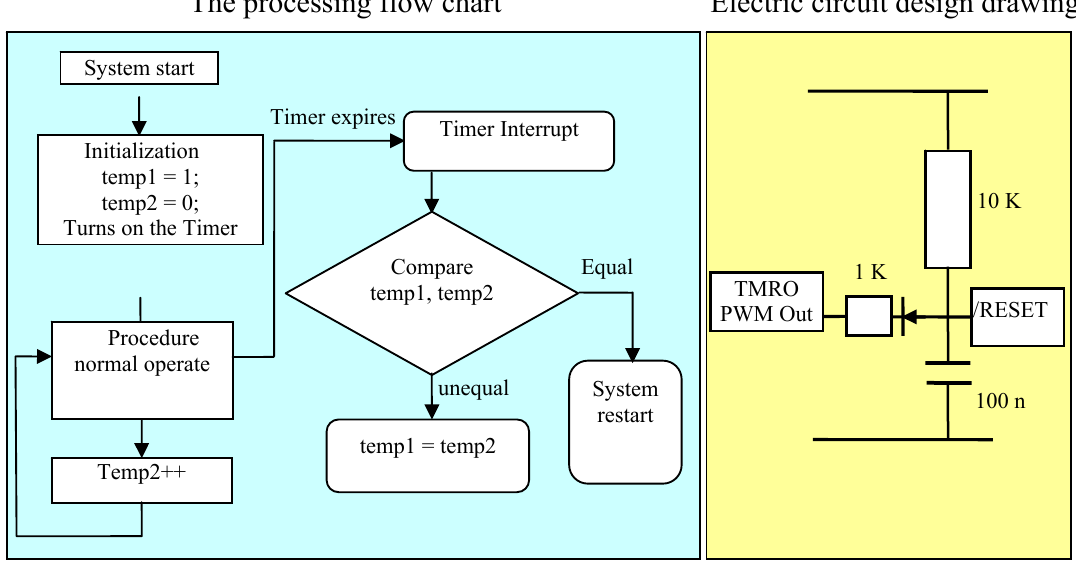
Figure 14. Flow chart of software watch-dog system, and circuit design of hardware